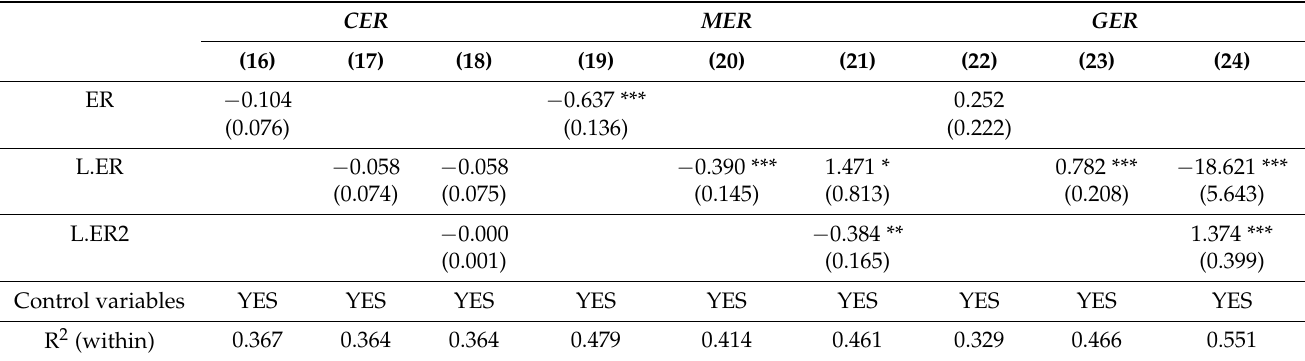
Table 6. Impact of environmental regulation on citrus GTFP (Fixed effect model).